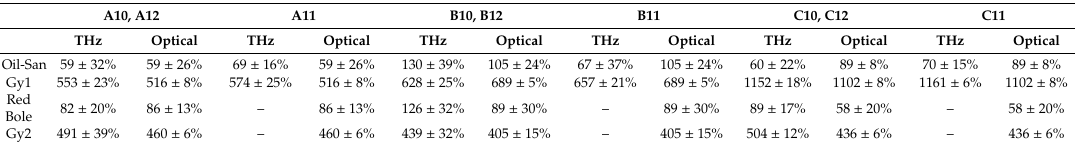
Table 4. THz estimate and optical measurement of layer thickness (in microns) of six areas covered by Sandrac-based varnish.